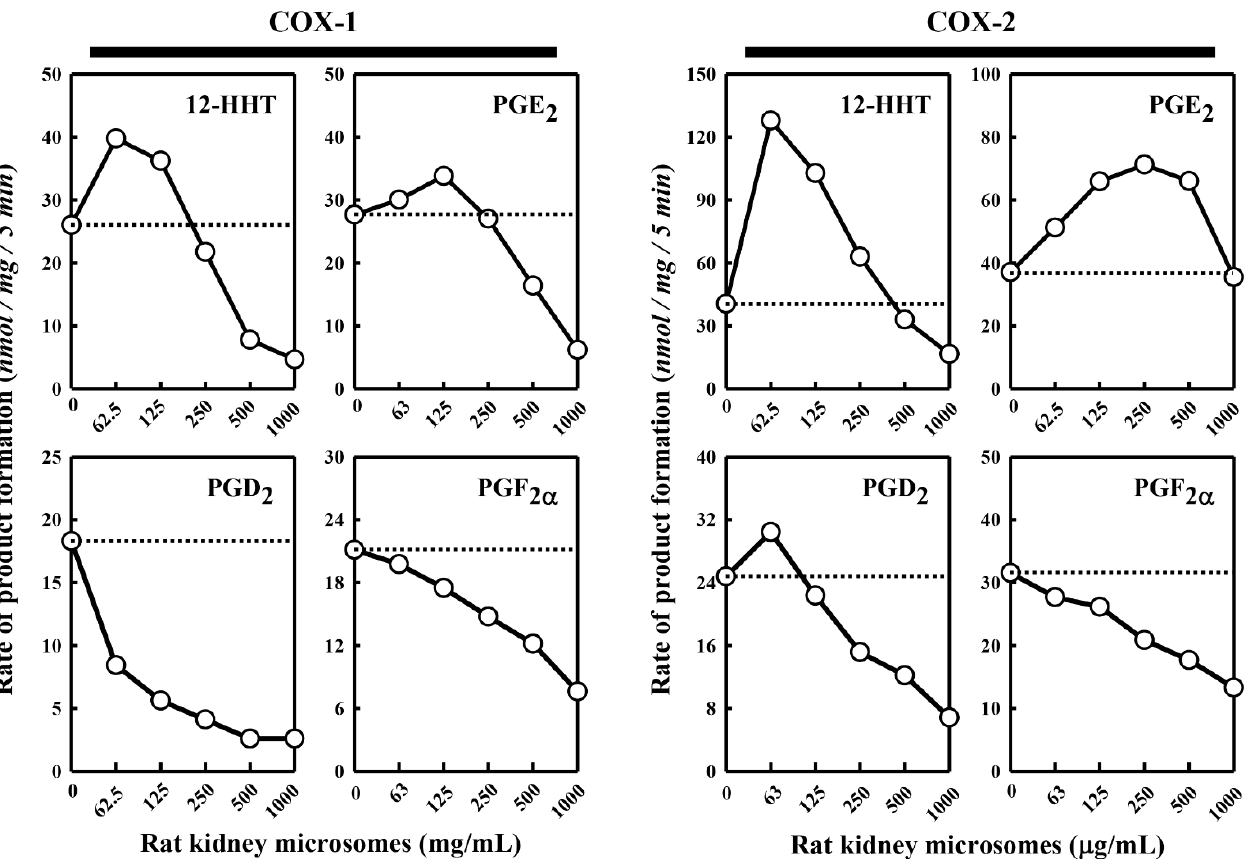
Figure 2. Effect of the rat kidney microsomes on COX-1 and COX-2-mediated conversion of [ 14 C]AA to major PG products. The incubation mixture consisted of six different concentrations (0, 62.5, 125, 250, 500 and 1000 μ g protein/mL) of the rat kidney microsomes, 20 μ M [ 14 C]AA (0.2 μ Ci) as substrate, 0.5 μ g/mL COX-1 or 0.97 μ g/mL COX-2 as the enzyme, 10 mM EDTA, 1 mM reduced glutathione, and 1 μ M hematin in 200 μ L of 100 mM Tris-HCl buffer, pH 7.4. The incubations were carried out at 37 °C for 5 min. The dotted line shows the control catalytic activity of COX-1 or COX-2 in the absence of the pig kidney microsomes. Each value is the mean of duplicate measurements, with small replicate variations (usually well below 10%).